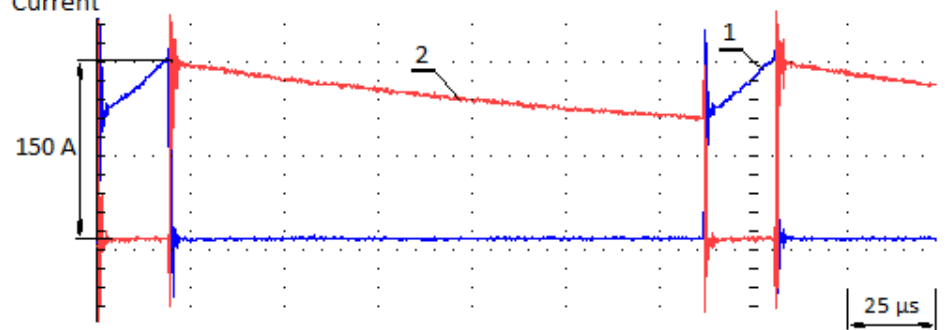
Figure 16. Boost mode of operation. 1–current through the Boost transistor Q1; 2–current through the diode D2.